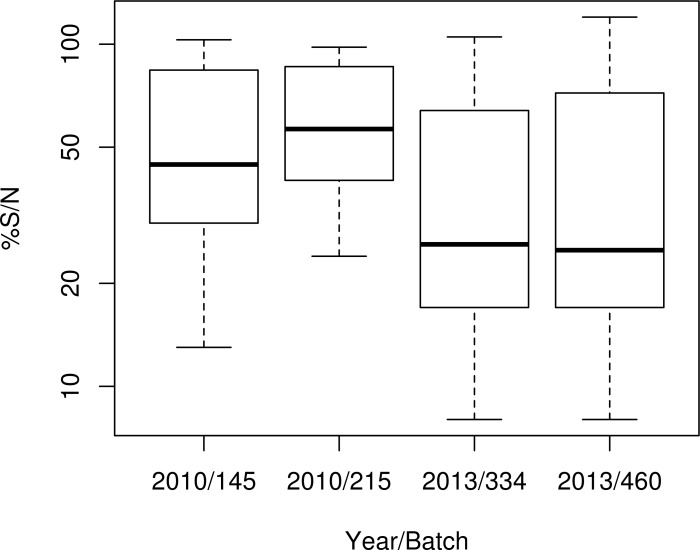
Box plot representing the distribution of %S/N obtained with the ID screen WNV competition kit by NRLs during the 2010 and 2013 ILPTs according to the year and batch.Assays were performed and %S/N was calculated according to the manufacturer’s instructions (the threshold value for considering a serum as positive by the competitive ELISA was %S/N < 40%).